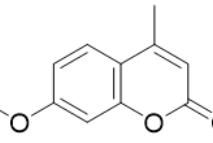
Figure 17. Chemical structure of 7-ethoxy-4-methylcoumarin (EMC).